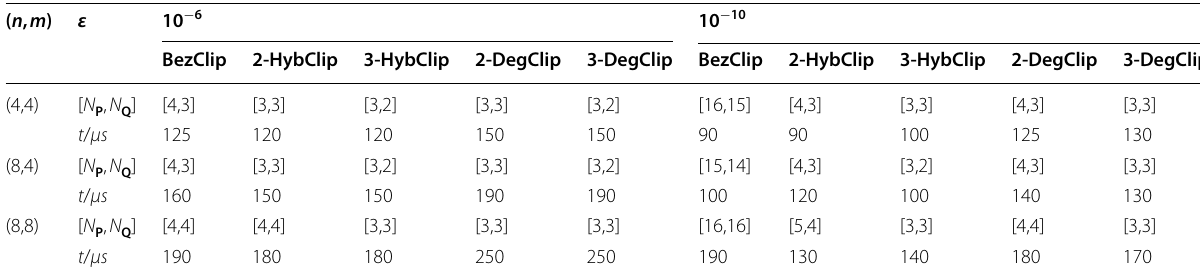
Number of iterations [ N P , N Q ] and computing time t (in microseconds) of accuracy ε . In addition, ( n , m ) are degrees of P , Q ,